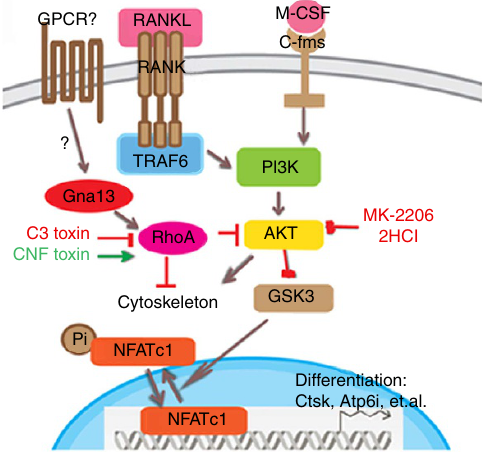
Figure 8 | Working model of G a 13 as a negative regulator in